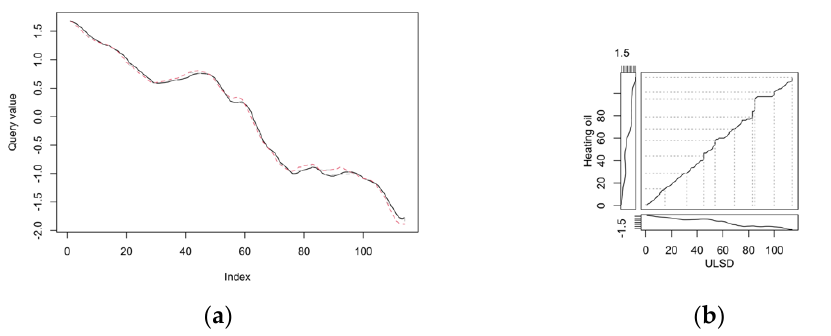
Figure 8. Alignment plots for ULSD and heating oil for the first subperiod. ( a ) Two-way, ( b ) Three-way. On the two-way plot the black solid line for ULSD, the red dashed line for heating oil. Source: own elaboration on the basis of data from www.stooq.com (accessed on 19 April 2021).